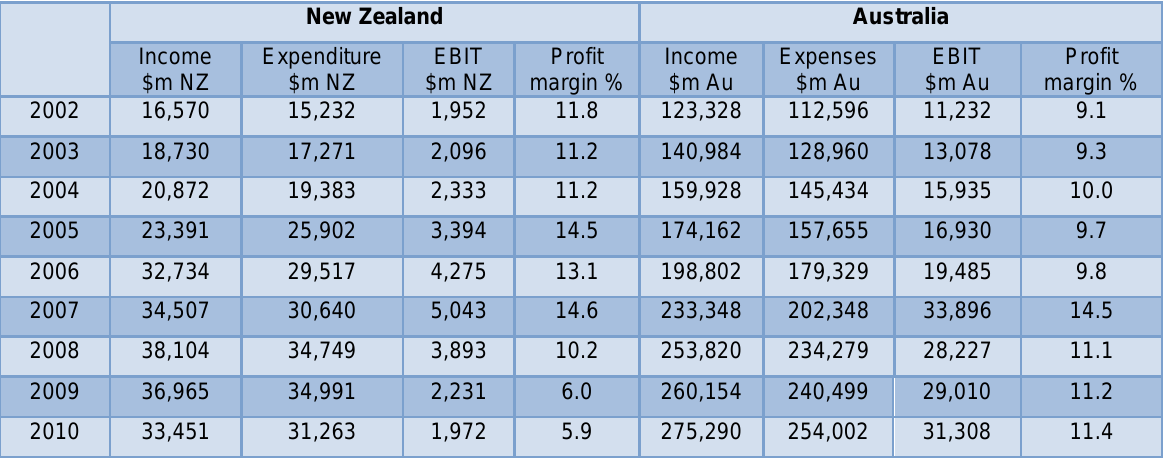
Table 2 Returns to business in the New Zealand and Australian construction